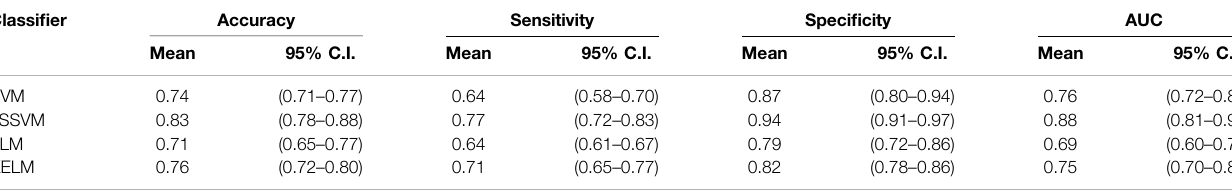
TABLE 4 | Summary of bearing fault classi fi cation